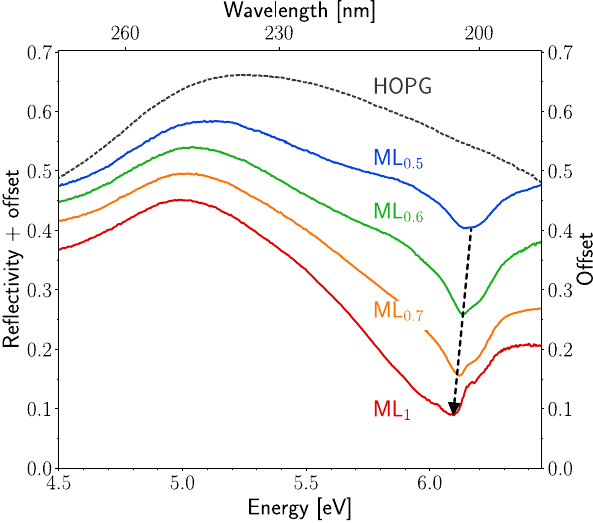
FIG. 3. Reflectivity spectra in the deep-ultraviolet range for a set of four atomically thin h -BN epilayers with a coverage up to a continuous monolayer, at 8 K. The offset is 0, 0.045, 0.09, and 0.135 for ML 1 , ML 0 , ML 0 , and ML 0 , respectively. The . 7 . 6 . 5 reflectivity spectrum of the bare graphite substrate (HOPG) is plotted in dotted gray line. The dashed line is a guide for the eye indicating the 70 meV redshift of the reflectivity